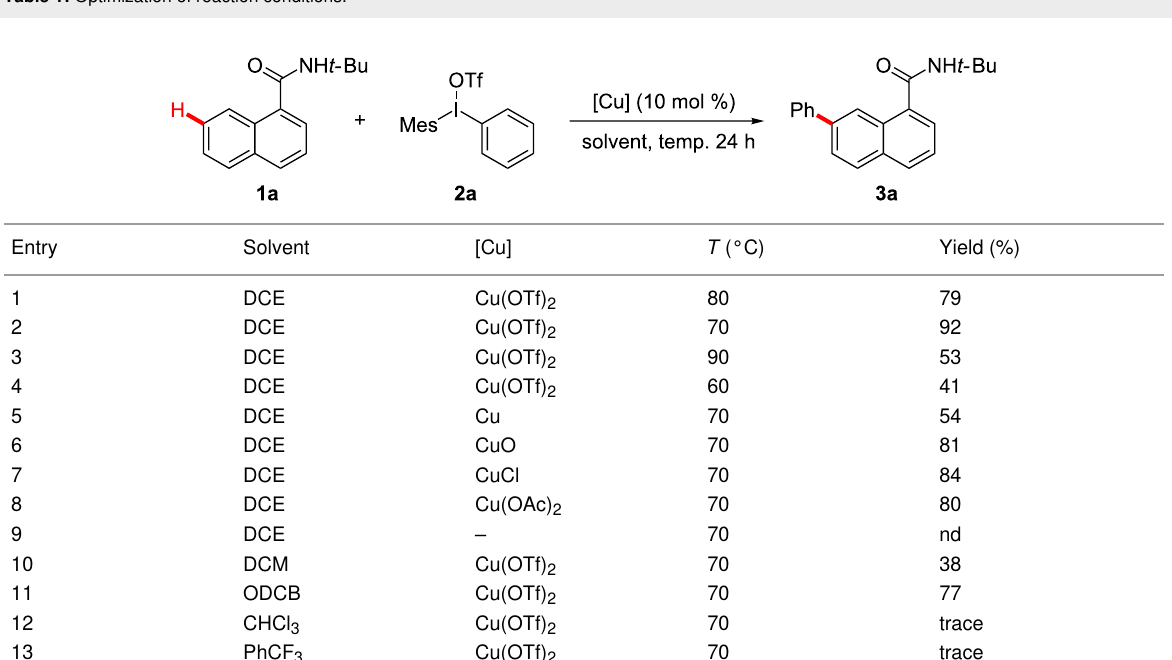
Table 1: Optimization of reaction conditions.